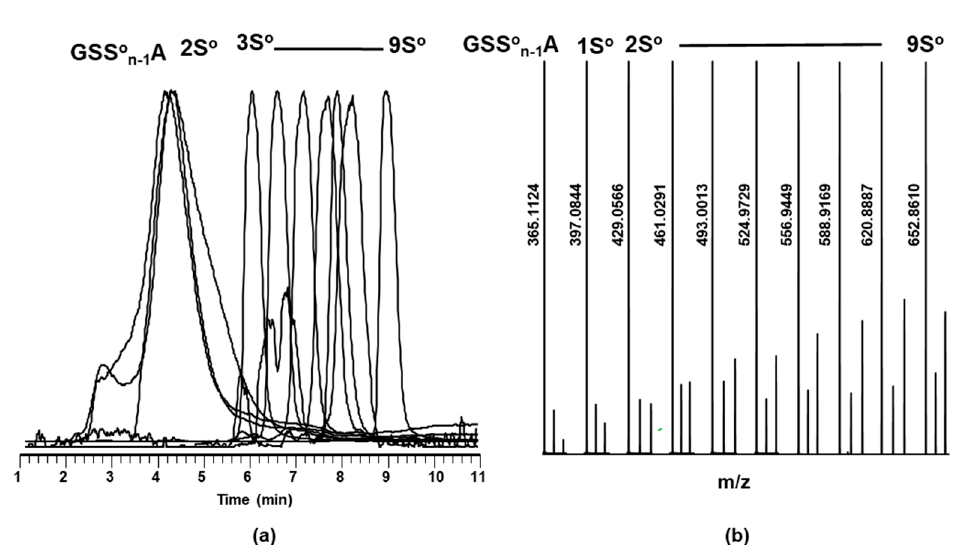
Figure 2. ( a ) Individual SICs glutathione polysulfane acetamide adducts obtained, RSS n CH 2 CONH 2 (n = 0–9) from LC/MS analysis of GSNO (1 mM) with an Na 2 S (1 mM) reaction in the presence of IA (5 mM) in iP buffer pH 7 and ( b ) their corresponding SIC MS.